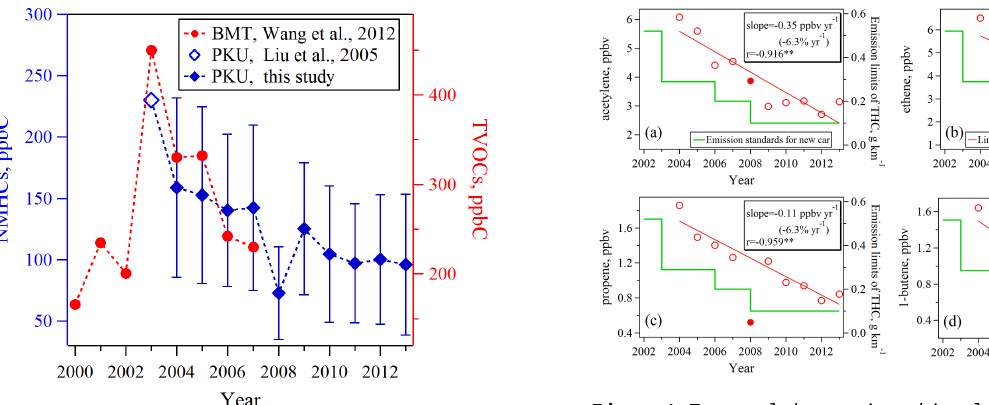
Figure 4. Temporal changes in ambient levels for (a) acetylene, (b) ethene, (c) propene, and (d) 1-butene measured at the PKU site during August from 2004 to 2013. The dark green staircase-pattern lines correspond to the emission limits of total hydrocarbons (THC) from light-duty vehicles. Owing to the influence from the short-term control measures for the Beijing Olympic Games, the measurement data for August 2008 (the red filled circle) were excluded from the linear fits. The trends that are significant at the 0.05 and 0.01 lev- els were marked by a single asterisk ( ∗ ) and a double asterisk ( ∗∗ ),